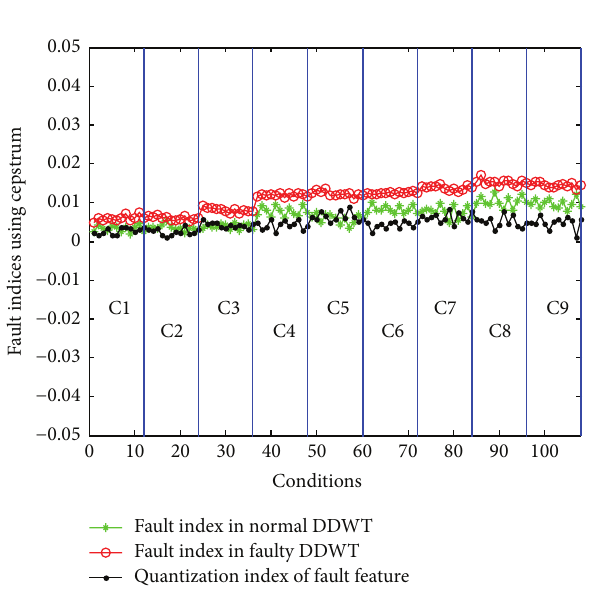
Figure 17: Fault indices using cepstrum analysis.